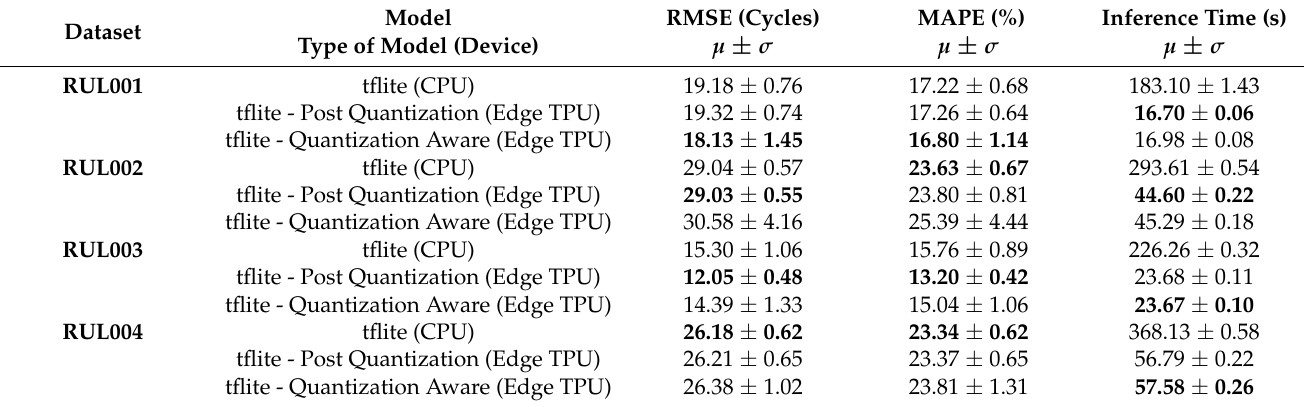
Table 3. Experimental results using the TIP4.0 default hardware (ClearFog Lite). The evaluation metrics were the RMSE, MAPE, and the inference time reported as the mean ± standard deviation across 30 repetitions. The best results are in bold.